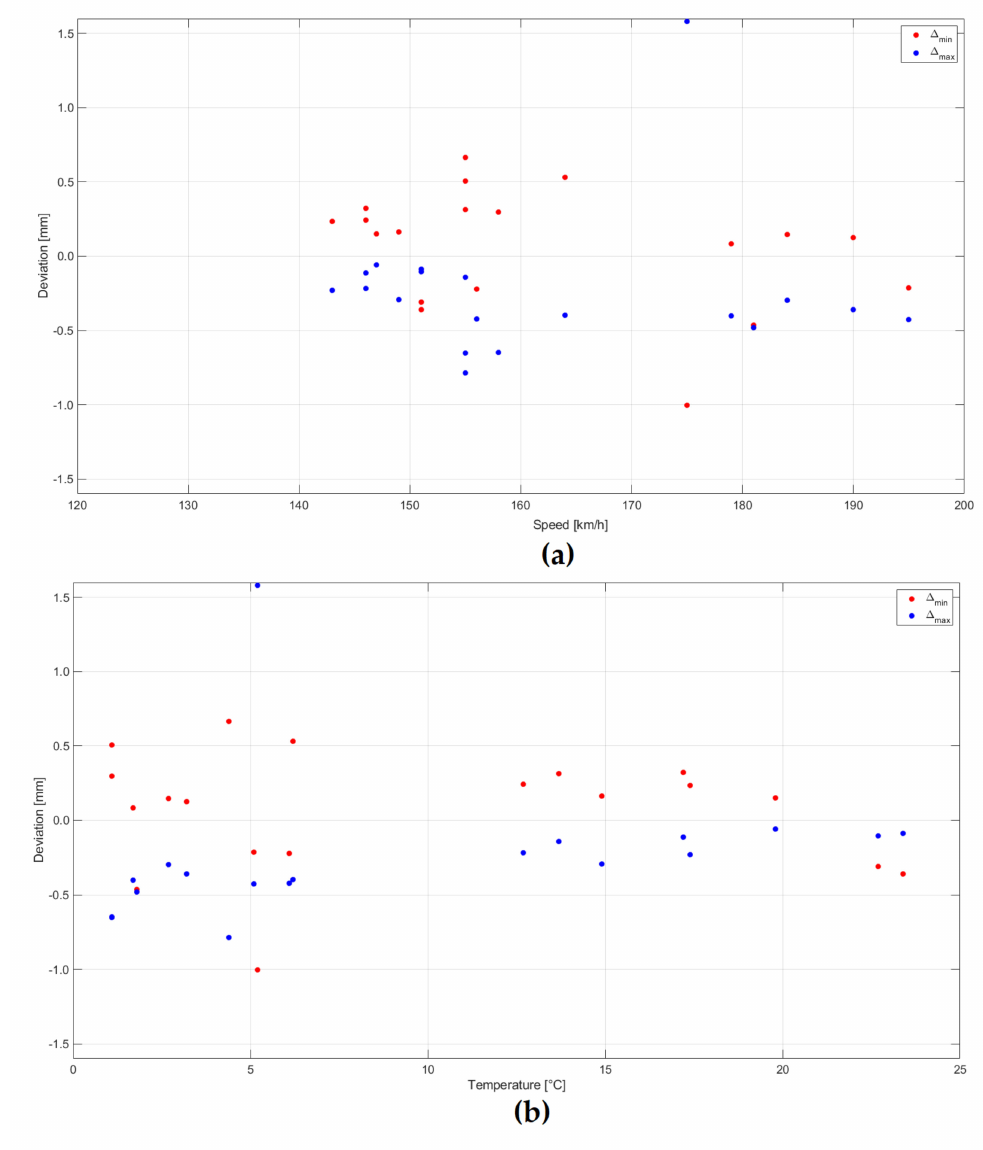
Figure 14. Analysis of the distribution of the measurement result deviation of extreme values in relation to reference measurements for multiple-unit trains (ED250) passages: ( a ) Depending on train speed and ( b ) air